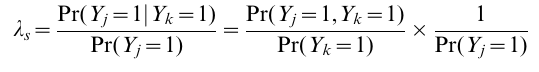
Figure S1 Average relative underestimation of effect size as a function of allele frequency and true effect size. Line plot shows the mean ratio of the effect size estimated from the most associated GWAS SNP to the true effect size at the causal locus. Lines are shown for 4 different risk allele frequency (RAF) bins. Figure S2 Posterior distribution on true relative risk when the minor allele is protective. Histograms showing the posterior distribution on the true relative risk (RR) conditional on observing an estimated relative risk and risk allele frequency (RAF) at the hit SNP. Results are shown using two different priors on RR and MAF: the blue histograms are the posterior distribution obtained using a conservative prior, and the red histograms are the posterior distribution obtained using the MAF-dependent prior. Figure S3 Posterior distribution on true relative risk for low estimated effect sizes. Histograms showing the posterior distribu- tion on the true relative risk (RR) conditional on observing an estimated relative risk and risk allele frequency (RAF) at the hit SNP. Results are shown using two different priors on RR and MAF: the blue histograms are the posterior distribution obtained using a conservative prior, and the red histograms are the posterior distribution obtained using the MAF-dependent prior. Figure S4 Priors on relative risks. Probability distributions of relative risk as a function of minor allele frequency for the MAF- dependent and conservative priors (the blue line). The MAF- dependent prior is pictured for five values of MAF Figure S5 Empirical prior on risk allele frequency. Cumulative distribution of the frequency of SNPs within the ENCODE regions used for simulations. At each SNP, each allele is chosen is turn chosen to be the risk allele so the distribution is symmetric around a half. Table S1 ENCODE regions used in simulations. The build 35 coordinates of the regions of HapMap CEU data used by HapGen to simulate genome-wide association study data. When simulating haplotypes and testing for association a 500kb buffer window was included either side of the listed regions.